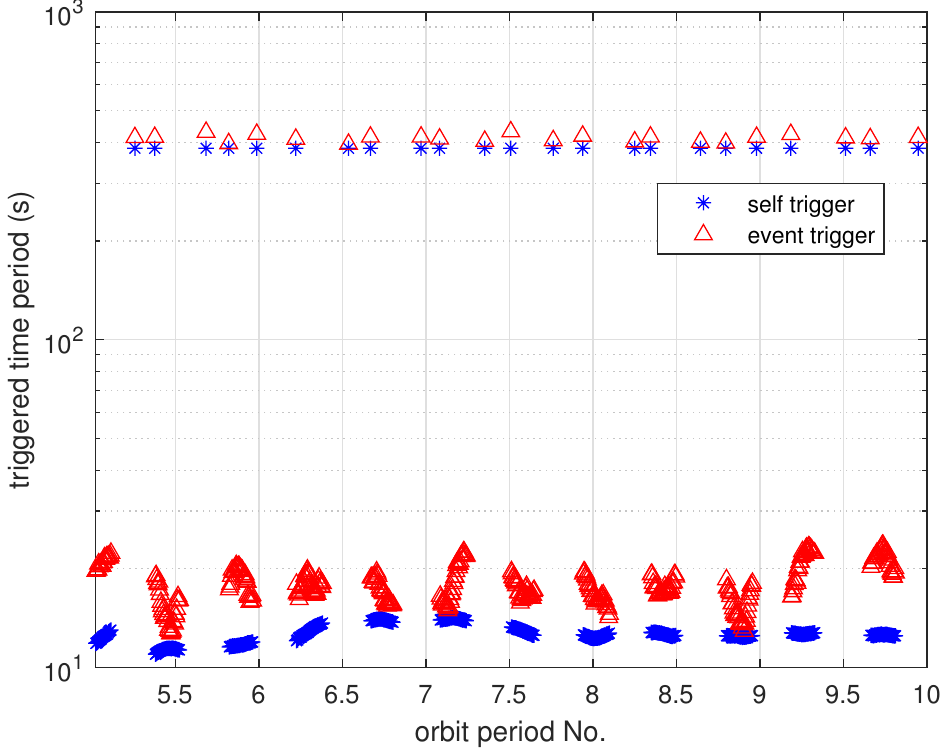
Figure 7. Sample period vs. orbit number for self-/event-triggered